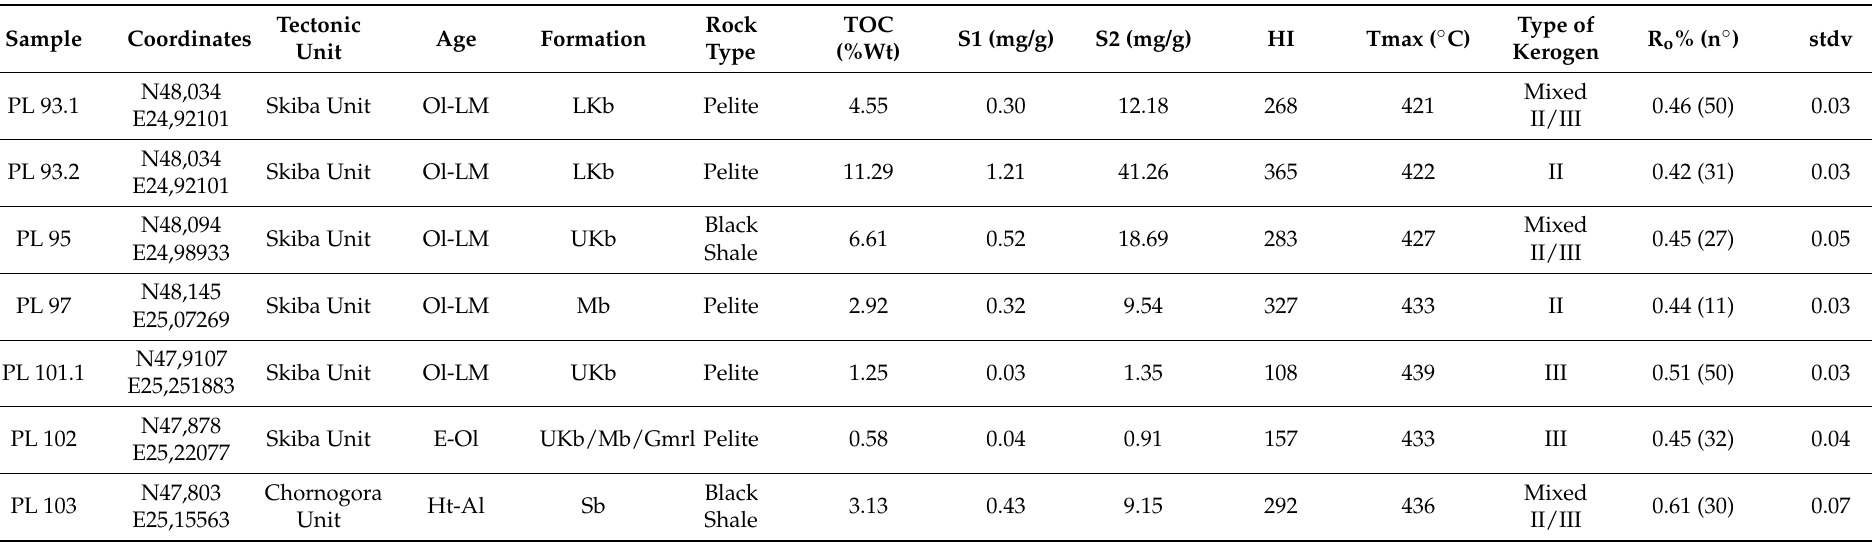
Table 2. Sample coordinates, geology and Pyrolysis Rock Eval data collected in the area. Acronyms: TOC—total organic carbon; HI—hydrogen index; Ol-LM: Oligocene to Lower Miocene; E-Ol: Eocene to Oligocene; Ht-Al: Hauterivian to Albian; LKb: Lower Krosno beds; UKb: Upper Krosno beds; Mb: Melinite beds; Gmrl: Globigerina marls; Sb: Shypots beds; stdv: standard deviation; n ◦ : number of